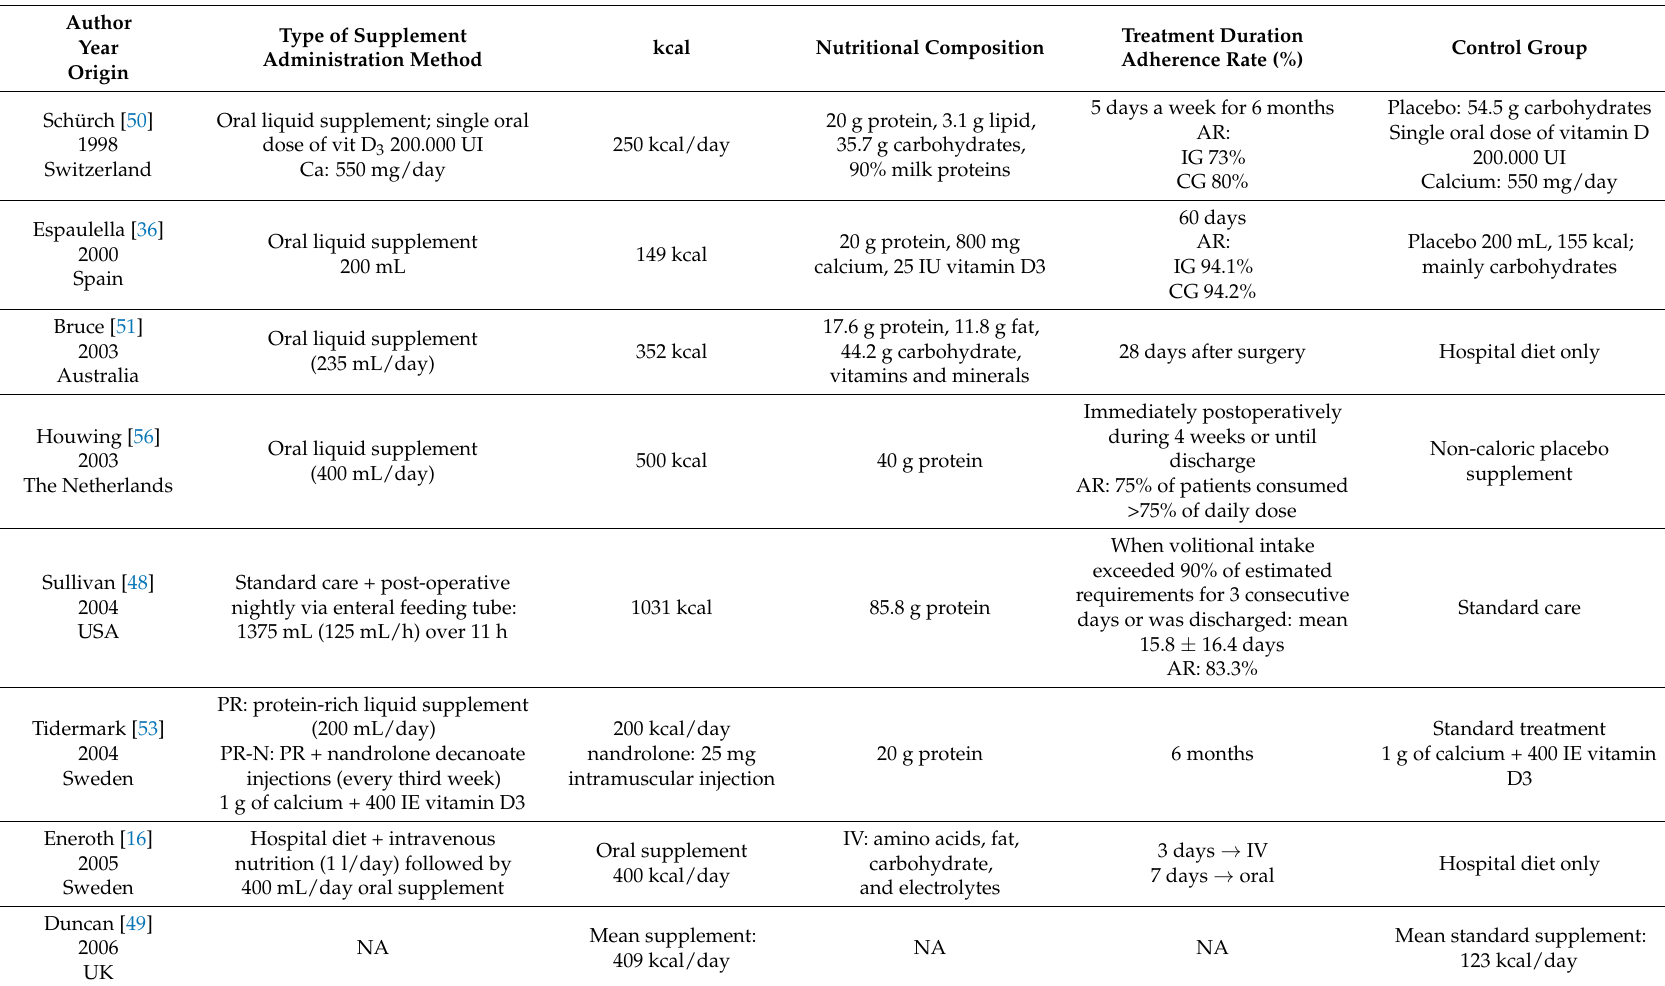
Table 7. Characteristics of the nutritional intervention and composition of the nutritional supplementation used in the included